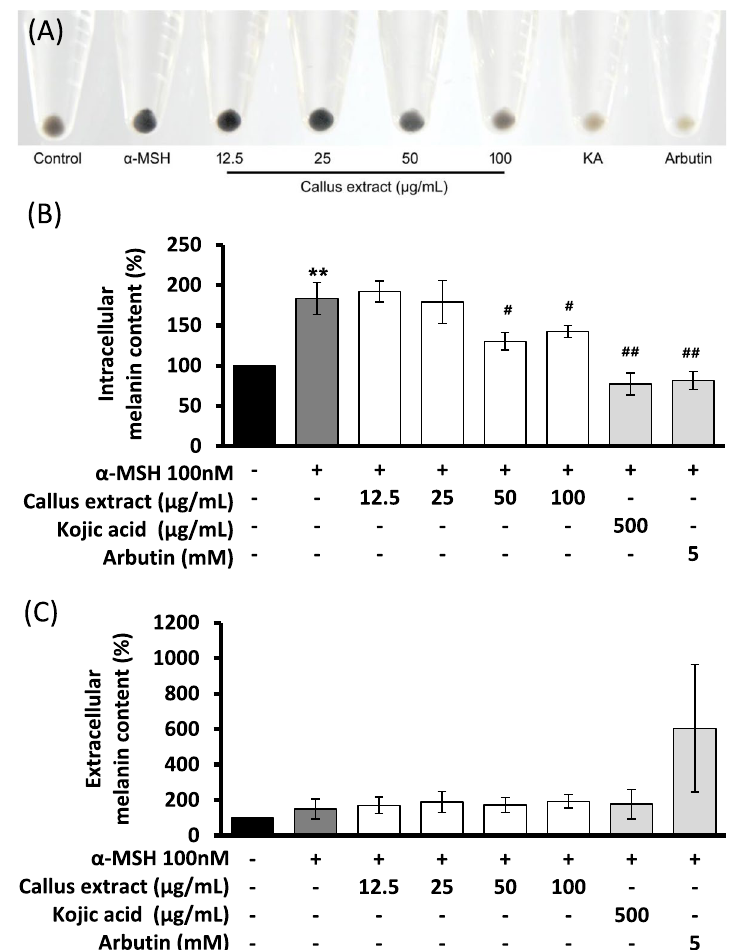
Fig. 6 Melanogenesis inhibitory effect of B. formosana callus extract in α‑MSH‑induced B16F10 mouse melanoma cells. A Cell pellet collection. B Relative intracellular melanin content. C Relative extracellular melanin content. The results were normalized with BCA. Data are presented as means SD of triplicate experiments. * p < 0.05, ** p < 0.01, and *** p < 0.001 compare with control. # p < 0.05, ## p < 0.01, and ### p < 0.001 compare ± with α‑MSH‑treated